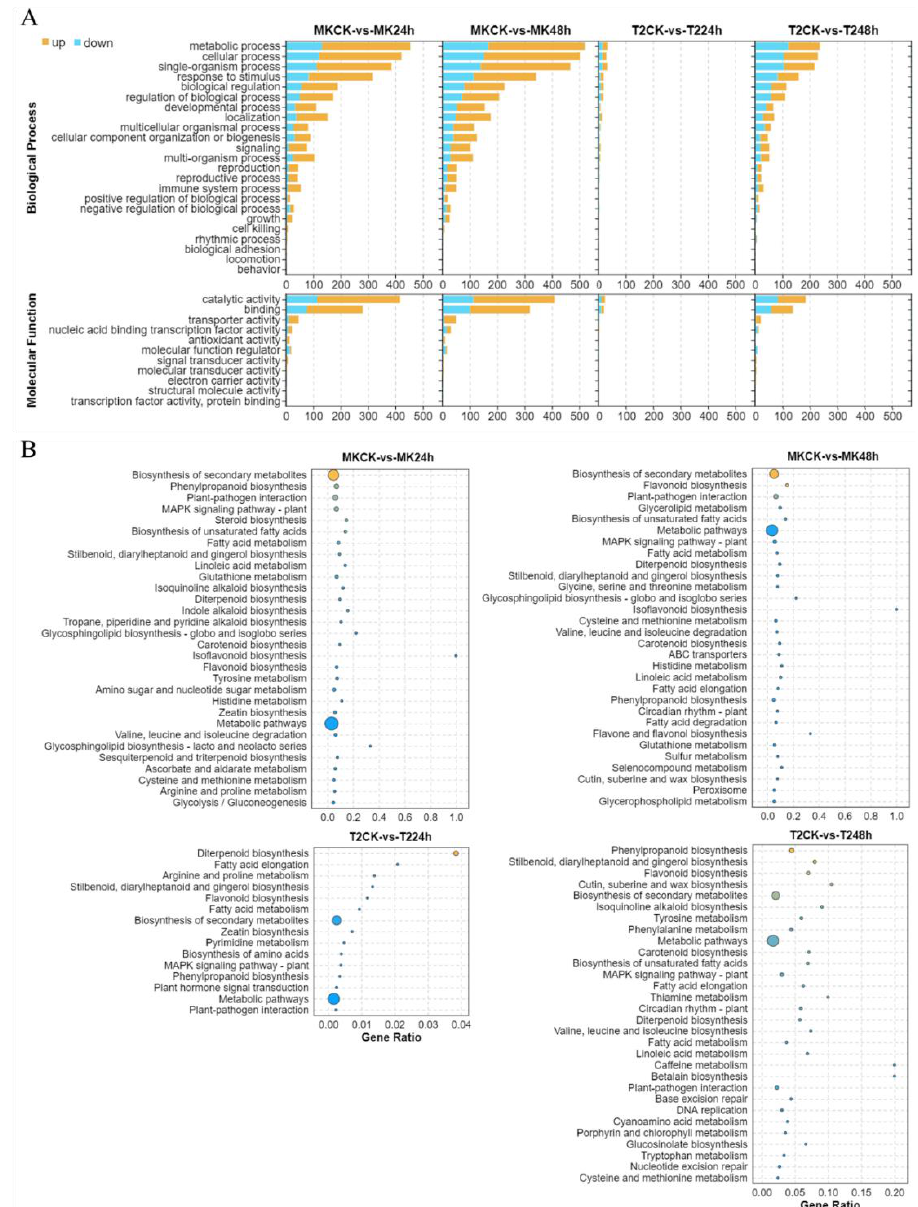
Figure 4. GO and KEGG categories of DEGs in MK and T2 under TYLCV infection. GO terms ( A ) and KEGG pathways ( B ) involved in TYLCV resistance. The X-axis in ( A ) indicates the DEG numbers in each GO term; the X-axis in ( B ) indicates the percentage of DEG numbers vs. the background gene numbers in each KEGG pathway. Detailed information is shown in Table S4.